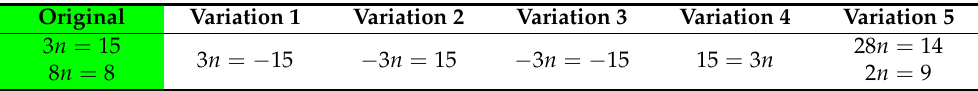
Table 15. Examples of type 4 equation variations with n as the